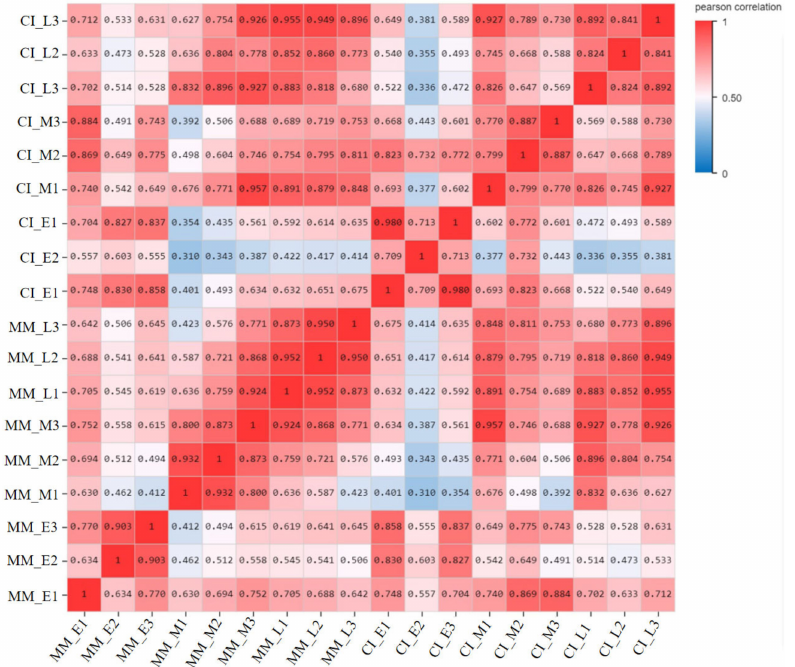
Figure 1. Pearson correlation coefficients of the 18 samples. The correlation coefficients between two samples are visualized as heat maps.